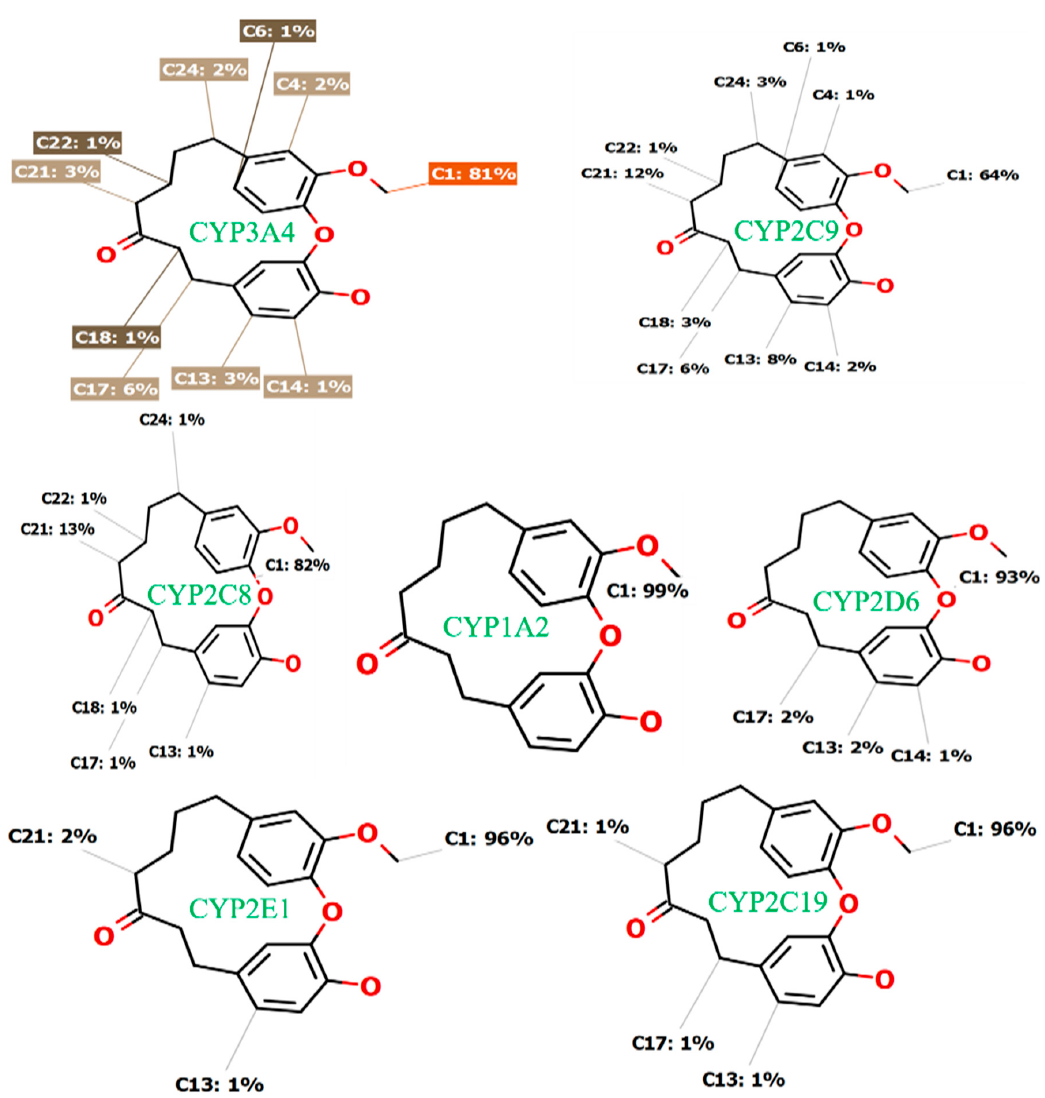
Figure 3. In silico results for CYP450 subtypes affecting galeon. (The picture was inserted directly from the StarDrop WhichP450™ software).